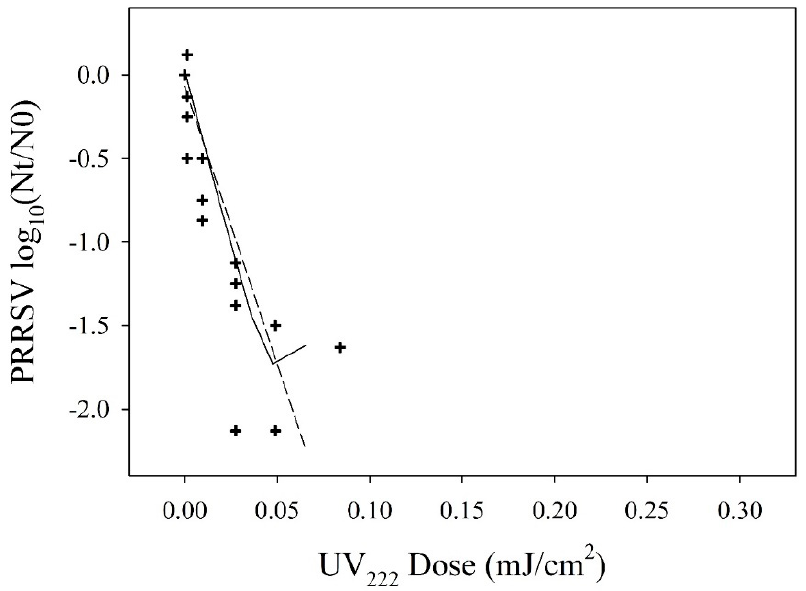
Figure A2. UV-C (222 nm) treatment inactivation curve on aerosolized PRRSV. One-stage (dashed line) and two-stage (solid line) inactivation curves were drawn. PRRSV survival is expressed as log 10 (N t /N 0 ), not as a percentage (%) as shown in Figure 3.